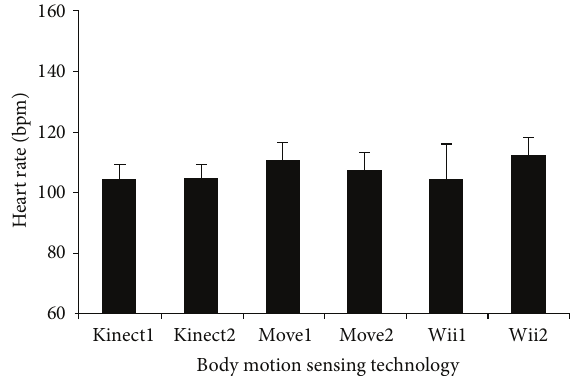
Figure 2: Heart rate (beats per minute) during each of the different dance routines using the various different body motion sensing technologies.Dataareshownasmean( 𝑛 = 9 )anderrorbarsindicate SEM.